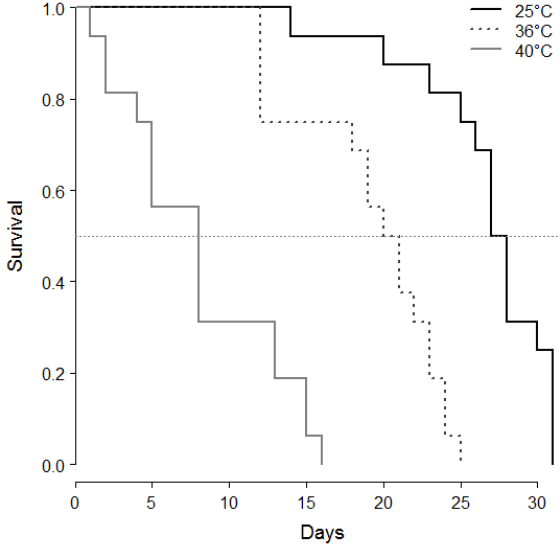
Figure 4. Survival of M. rufiventris virgin males fed with honey at 25 ◦ C. Three series are 25 ◦ C— developed continuously at 25 ◦ C ( n = 39), 36 ◦ C—developed at 25 ◦ C with a 1-day heat period at 36 ◦ C at early pupal stage ( n = 40), 40 ◦ C—developed at 25 ◦ C with a 1-day heat period at 40 ◦ C at early pupal stage ( n = 40). Dashed horizontal line indicates 50% of survival. log-rank test, Chi²= 59.4, df = 2, p < 0.001.